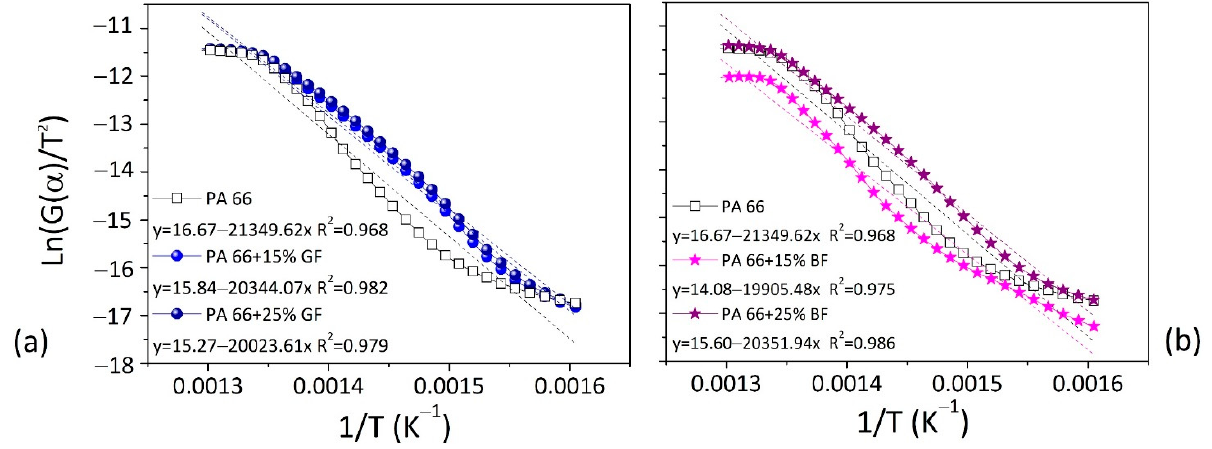
Figure 3. The Coats–Redfern method for PA 66 + GF composites ( a ) and PA 66 + BF composites ( b ). Table 2. Kinetic parameters using CR